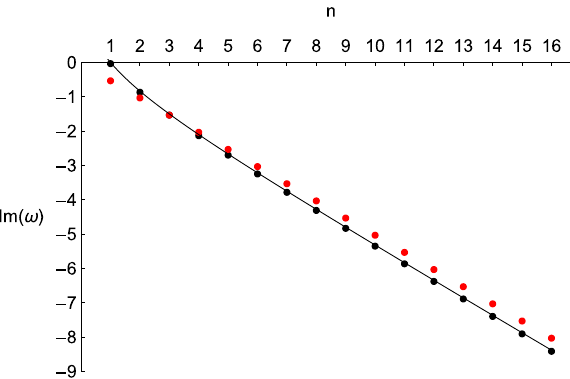
Fig. 2 Red and black dots correspond to the pole-skipping points and quasinormal modes, respectively. We fit the QNMs (black dots) with a thin black line to make the comparison more obvious. The frequencies of pole-skipping points are close to those of QNMs ( c s =1/4)